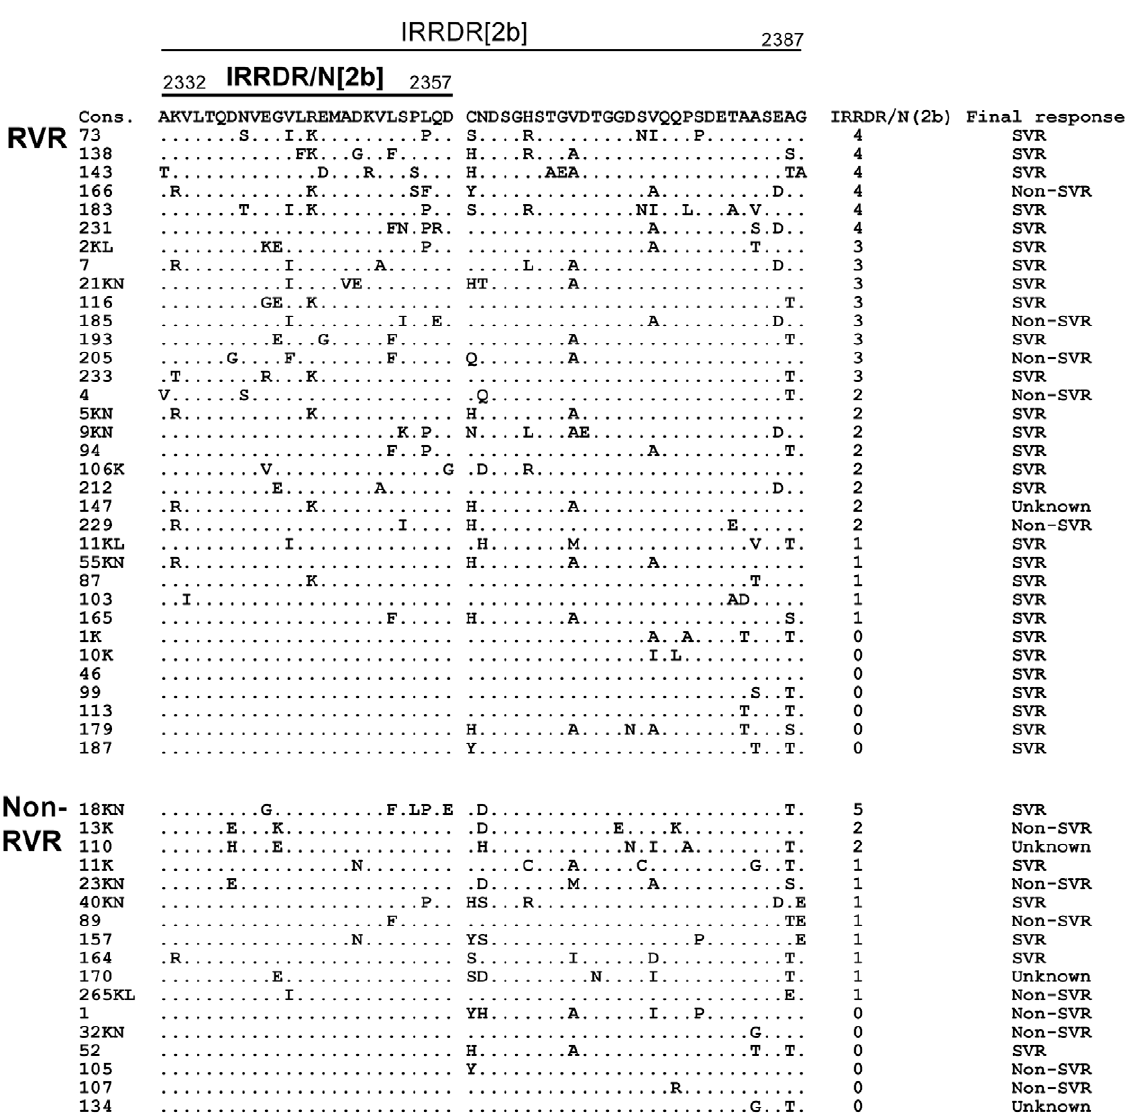
Figure 3. Sequence alignment of NS5A of HCV-2b isolates. Sequences of IRRDR/N[2b] (an N-terminal part of interferon/ribavirin resistance- determining region of HCV-2b) obtained from RVR and non-RVR patients are aligned. The consensus sequence (Cons) is shown on the top. The numbers along the sequence indicate the aa positions. Dots indicate residues identical to those of the Cons sequence. The numbers of the mutations in IRRDR/N[2b] and the final treatment outcome of each patient are shown on the right.